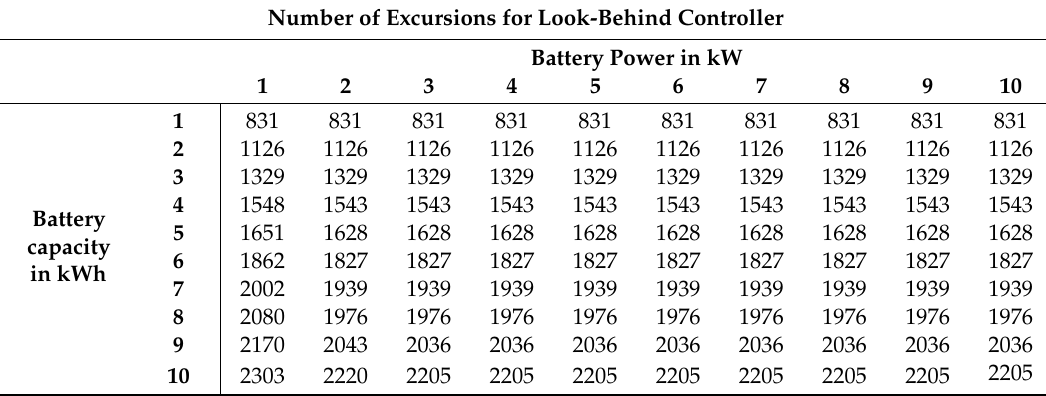
Table A4. Number of excursions for look-behind controller. Number of Excursions for Look-Behind